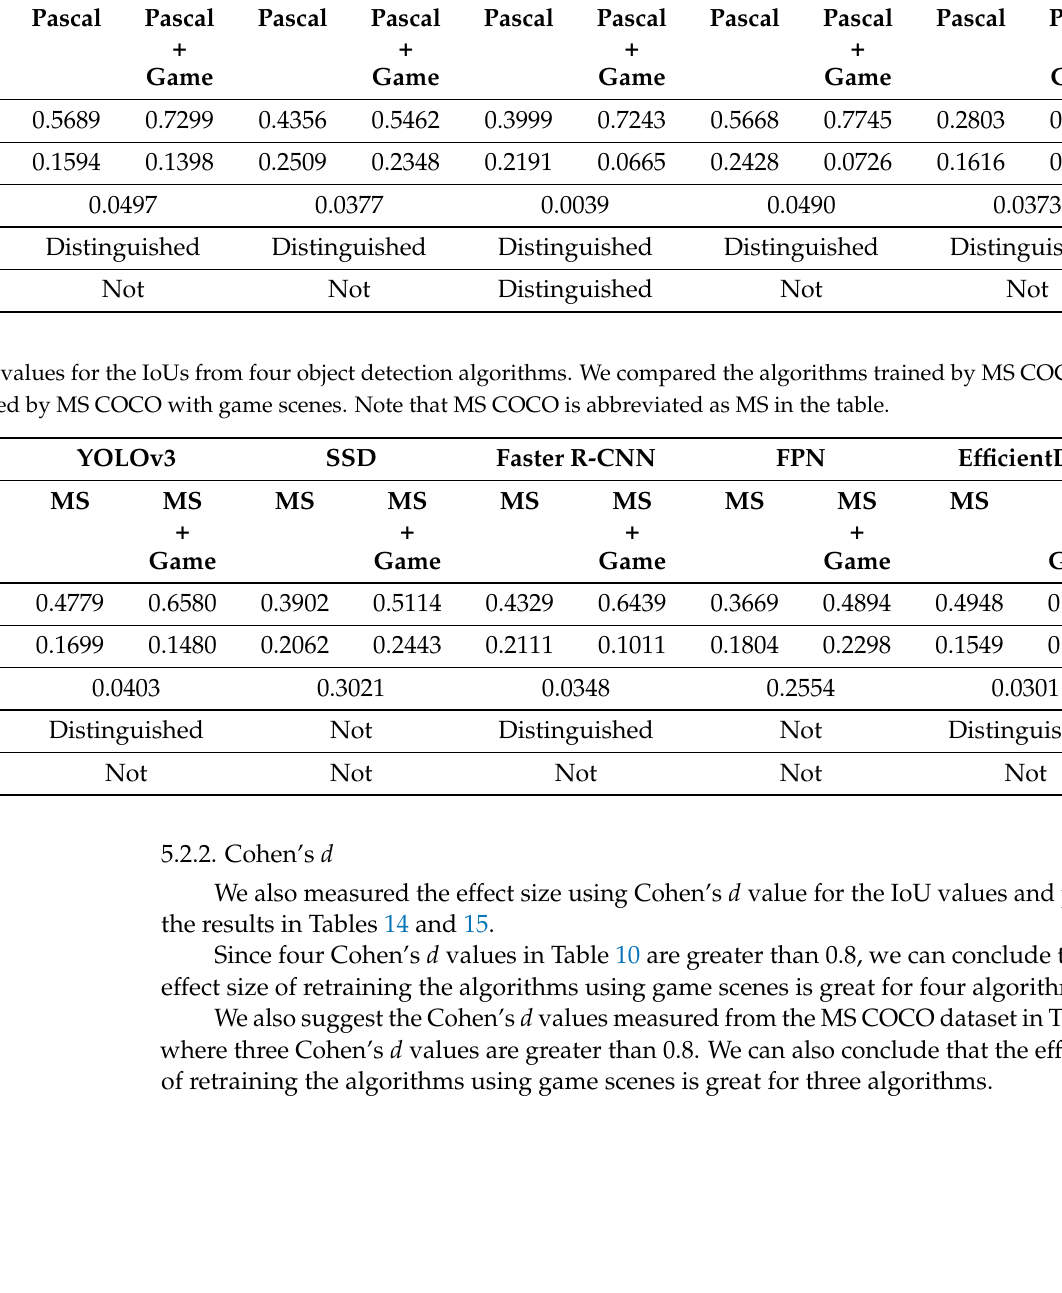
Table 12. p values for the IoUs from four object detection algorithms. We compared the algorithms trained by PascalVOC and retrained by PascalVOC with game scenes. Note that PascalVOC is abbreviated as Pascal in the table. Algorithm